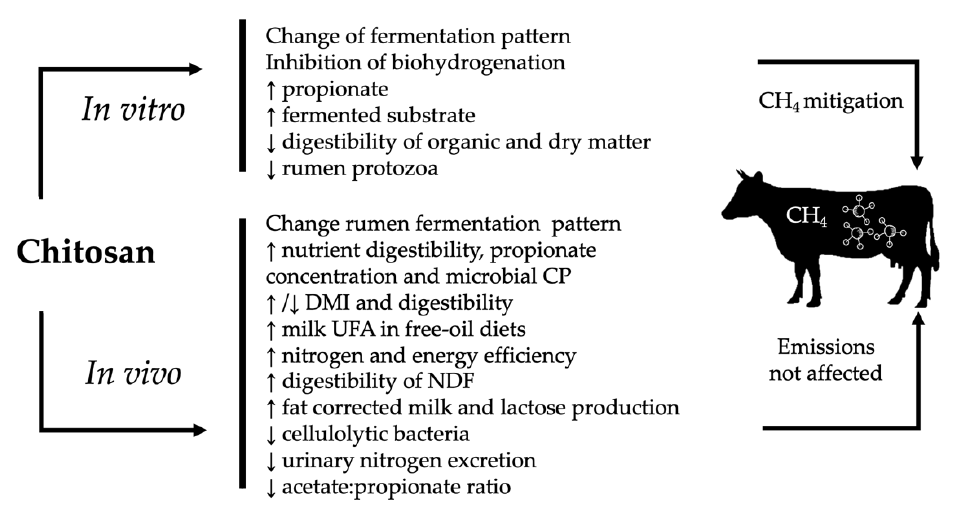
Figure 3. Mechanisms of action of chitosan described in the in vivo and in vitro experiments.